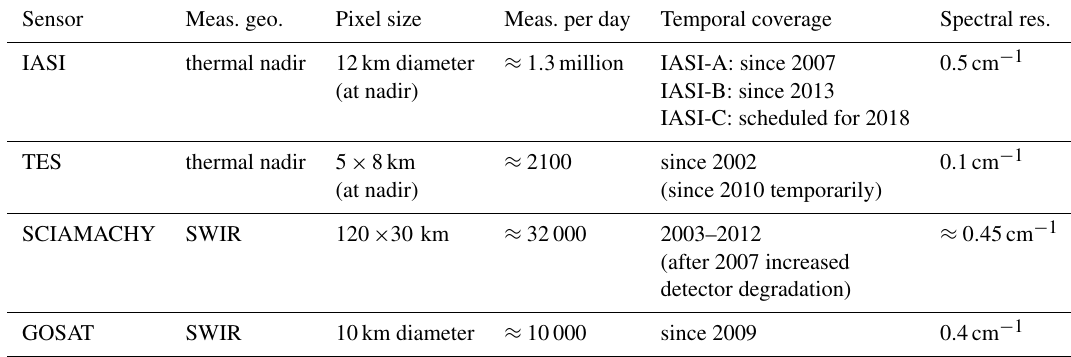
Table B2. Space-based sensors with available tropospheric water vapour isotopologue retrieval